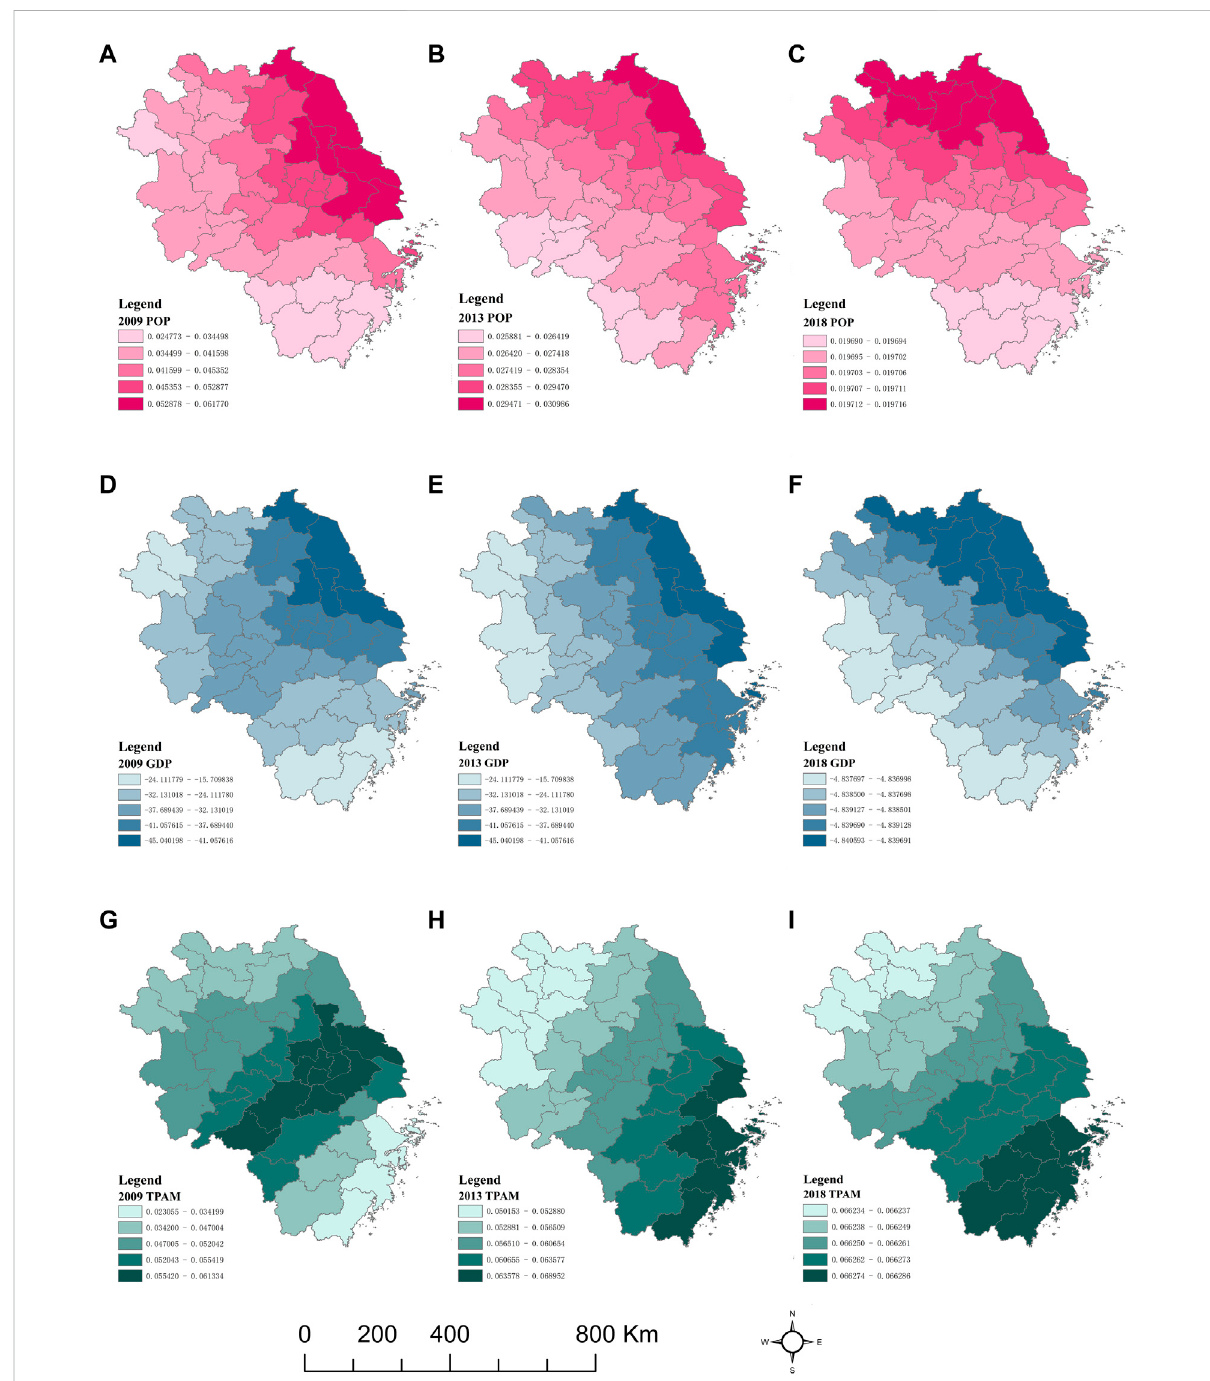
FIGURE 8 Spatialdistributionofregressioncoef fi cientsofGWRmodelinYangtzeRiverDeltafrom2009to2018. (A – C) representthespatialdistributionof regression coef fi cients of POP in 2009, 2013, and 2018, respectively. (D – F) represent the spatial distribution of regression coef fi cients of GDP in 2009, 2013,and 2018,respectively. (H – G) representthespatial distributionofregressioncoef fi cientsofTPAM